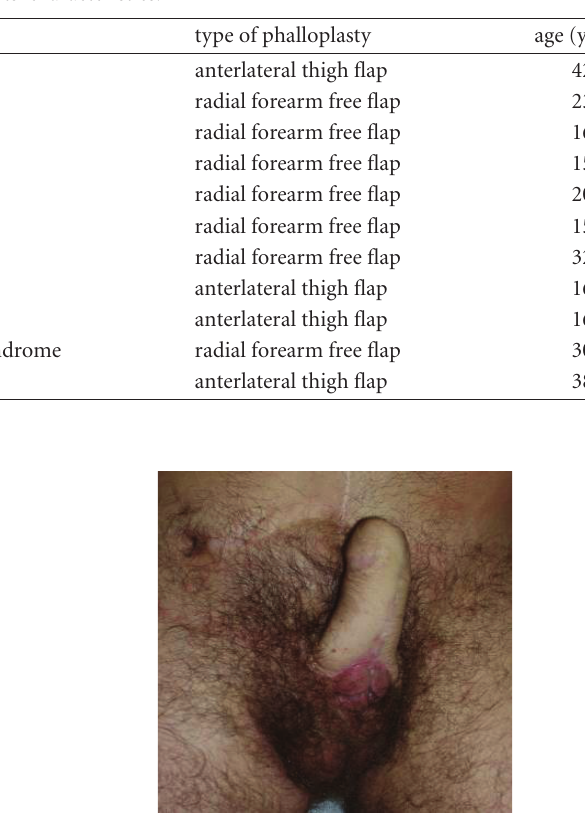
Figure 1: Incorporation of residual penile tissue at the base of the